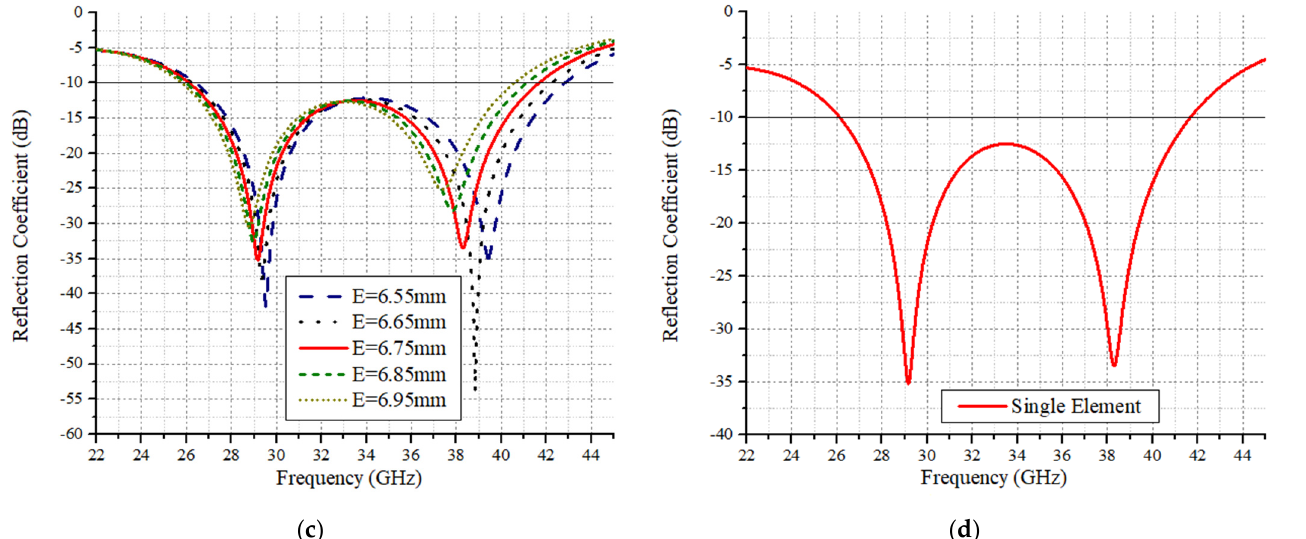
Figure 2. Parametrical studies for ( a ) slot length (DD), ( b ) distance among circular loops ( c ) feedline length (E) and ( d ) single element.